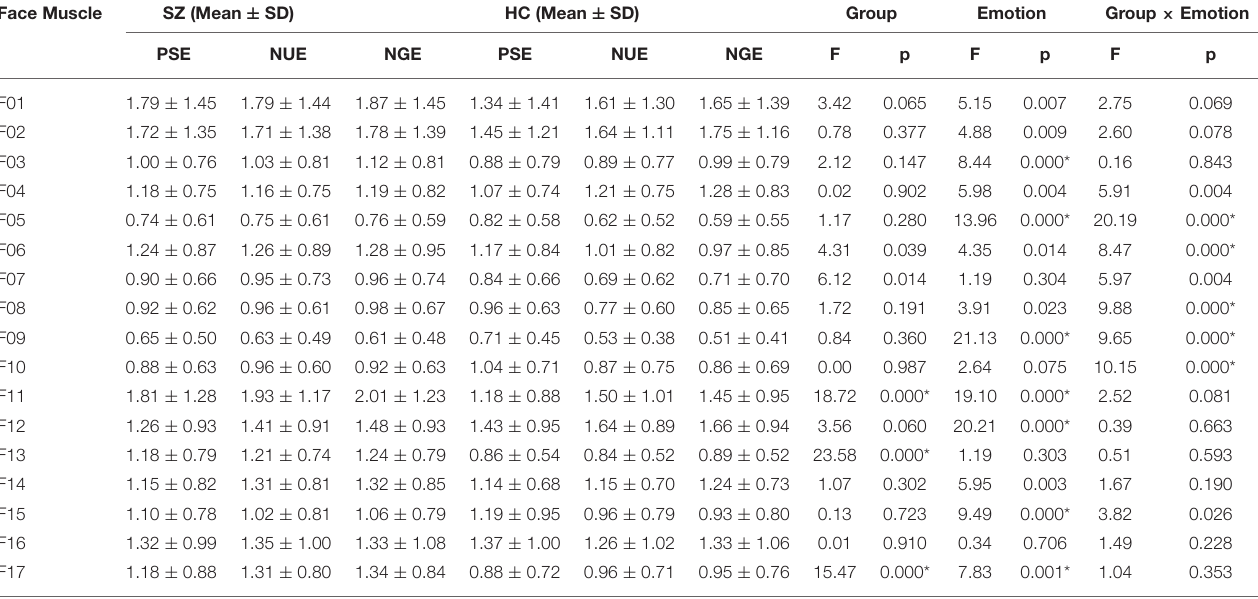
TABLE 2 | Comparison of facial muscle activity intensity between the schizophrenia group and the healthy control group under three different emotional stimuli conditions. Face Muscle SZ (Mean ± SD) HC (Mean ± SD) Group Emotion Group ×